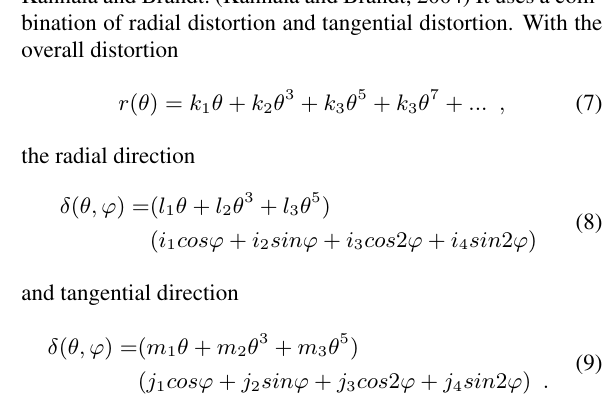
algorithm for each image a approximate The image processing software performs the point numbering and measurement auto- matically. Therefore, groups of four points are built twice on each plane allowing an exterior and interior orientation are es- timated, considering the equidistant projection